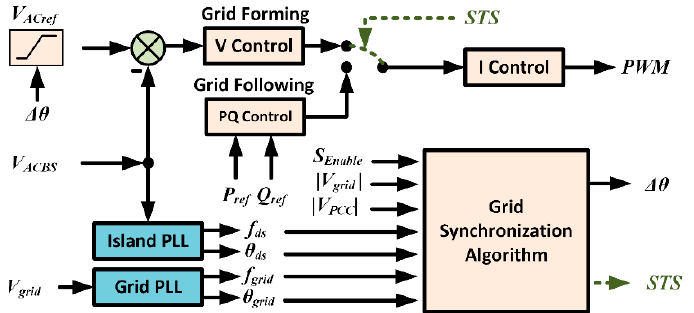
Figure 6. High ‐ level EMS control design for AC black ‐ start and synchronization operating modes. Figure 6. High-level EMS control design for AC black-start and synchronization operating modes.